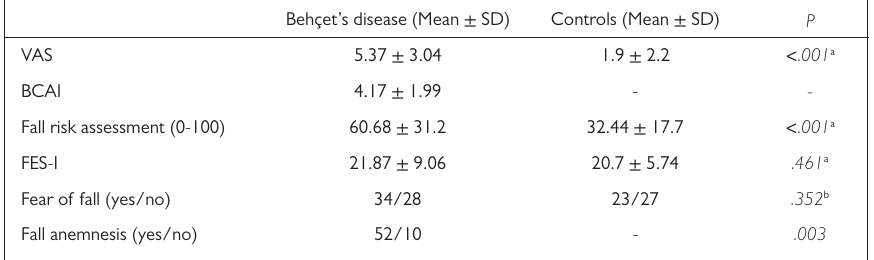
Table 3. The Clinical Parameters of Participants